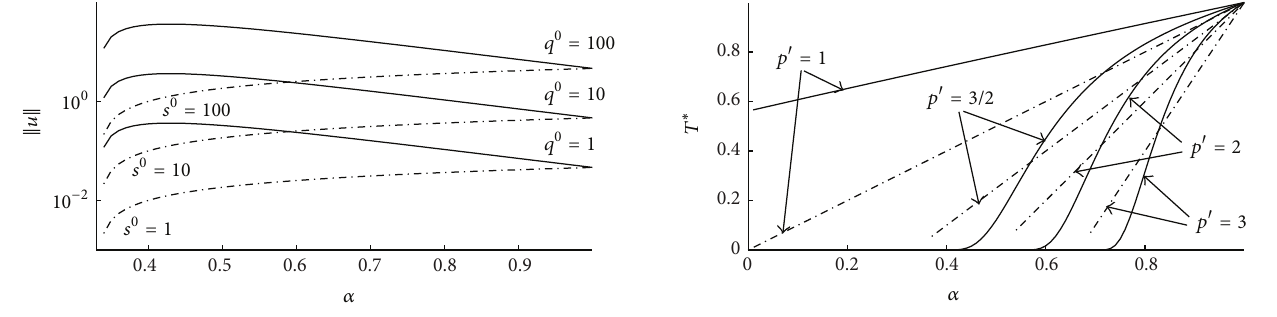
Figure 5: The dependencies for minimal control time from 𝛼 .